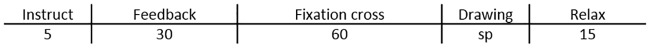
Time course of trials (in seconds).Each trial started with a screen announcing that feedback was about to be shown and reminded participants which perspective (self-immersed or self-distanced) to adopt (Instruct). Subsequently, while adopting the instructed perspective, participants had to read one of the negative (six trials per run) or neutral (four trials per run) feedback that was presented (Feedback), and to think about it while adopting the instructed perspective as long as a fixation cross appeared on the screen (Fixation cross). Immediately afterwards, they were asked to draw an intensity profile reflecting the changes in negative affect they experienced while reading and thinking about the feedback using the emotion intensity profile tracking approach (Drawing). To reduce carryover effects, participants were asked to relax before a new trial started (Relax). sp = self-paced.